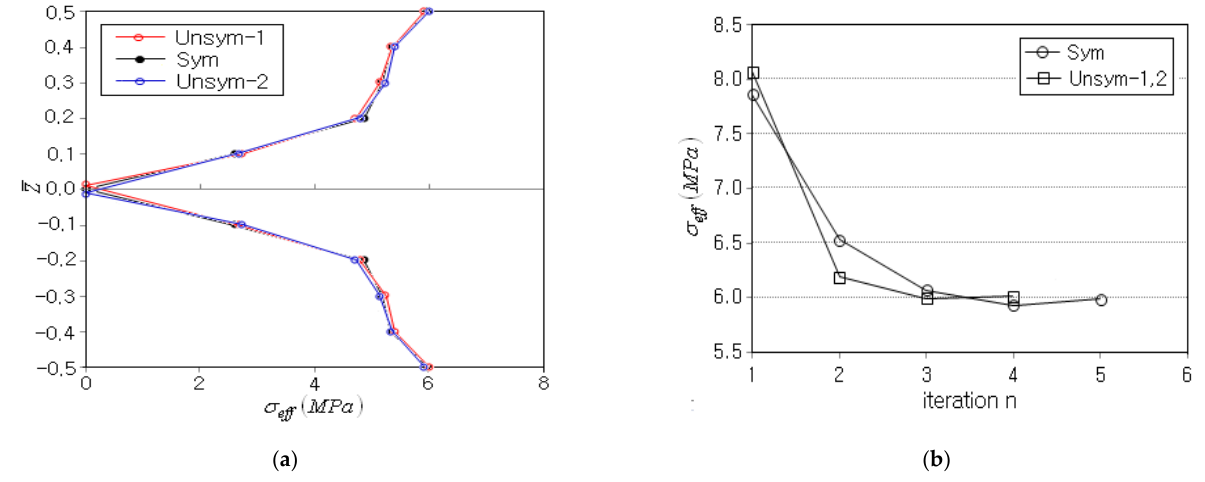
Figure 8. Comparison: ( a ) effective stress distributions e ff for the optimal CNT distribution, ( b ) iteration histories of the objective function.